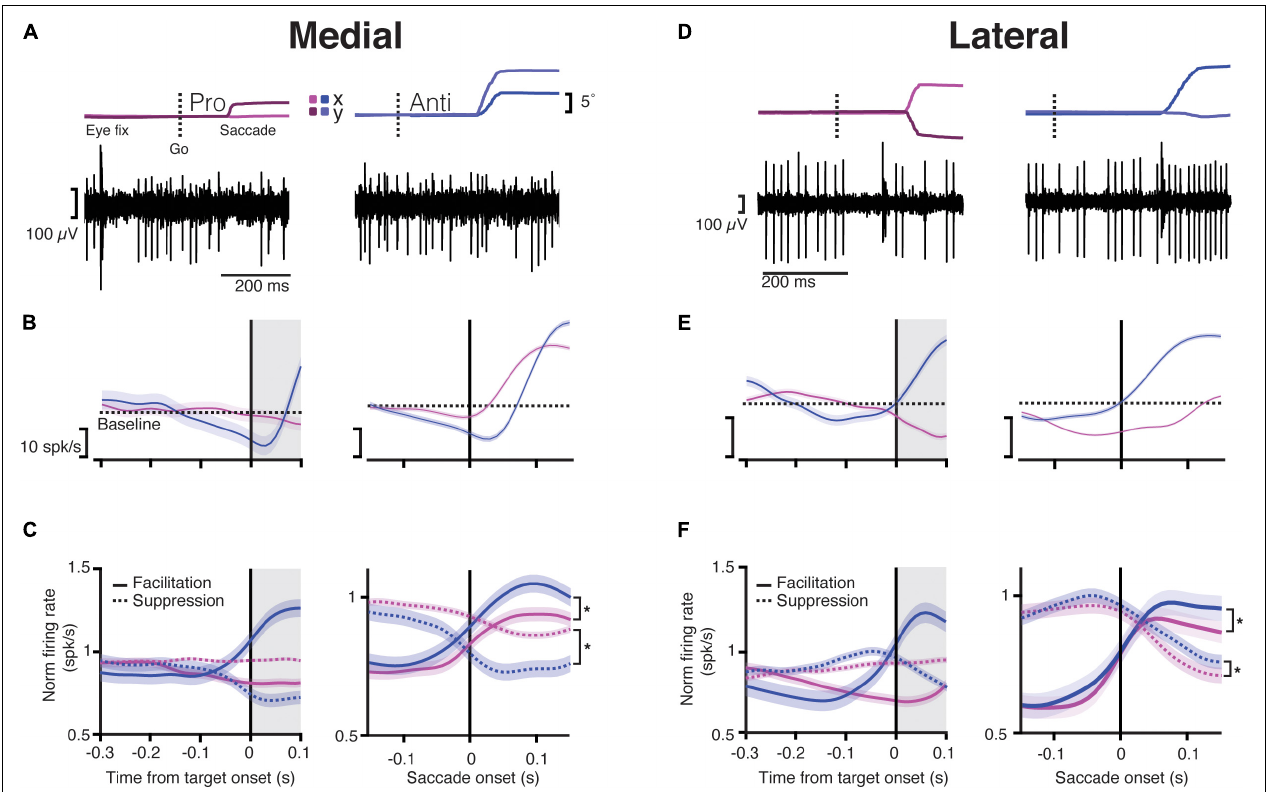
FIGURE 2 | Purkinje cells in both the medial and lateral cerebellum start modulating their activity during the instruction period. (A) Top, Eye trace for an example trial during the saccade onset for a pro- (left) and anti-saccade (right). The dashed line indicates the time of the “go” cue. Dark and light magenta and blue show the x and y positions (horizontal and vertical components) of the eye trace for pro- and anti-saccades, respectively; bottom, traces of activity recorded from a PC in the medial cerebellum for a single trial aligned to the eye trace indicated above. Note that the traces include many simple spikes (SSs; smaller spikes) and only a few complex spikes (CSs, bigger spikes). (B) Top, Raster plots of trials showing the activity of five different neurons aligned to the end of the instruction period (target onset; left) or to the saccade onset (right) for prosaccades (magenta) and antisaccades (blue) for the medial cerebellum; bottom, the average response time-course for one example neuron aligned to the same periods during the same conditions. The dashed line shows the baseline mean. Shaded regions denote SEM. Gray shaded areas show the time after the instruction period when the target appears, but the animals must keep fixating on the central dot. (C) Time-course of normalized responses averaged for all neurons in the medial cerebellum that either increased their firing ( facilitation cells, solid line) or decreased it ( suppression cells, dashed lines) aligned with the target onset (left) or the saccade onset (right). Asterisk denotes significant statistical comparisons after the saccade onset, facilitation pro vs. anti: p = 1.61 × 10 − 7 , suppression pro vs. anti: p = 5.3 × 10 − 23 . (D) Same as in (A) but for lateral cerebellum. (E) Same as in (B) but for lateral cerebellum. (F) Same as in (C) for the lateral cerebellum (asterisk denotes significant difference between facilitation pro vs. anti: p = 1.08 × 10 − 17 , suppression pro vs. anti: p = 4.4 × 10 − 9